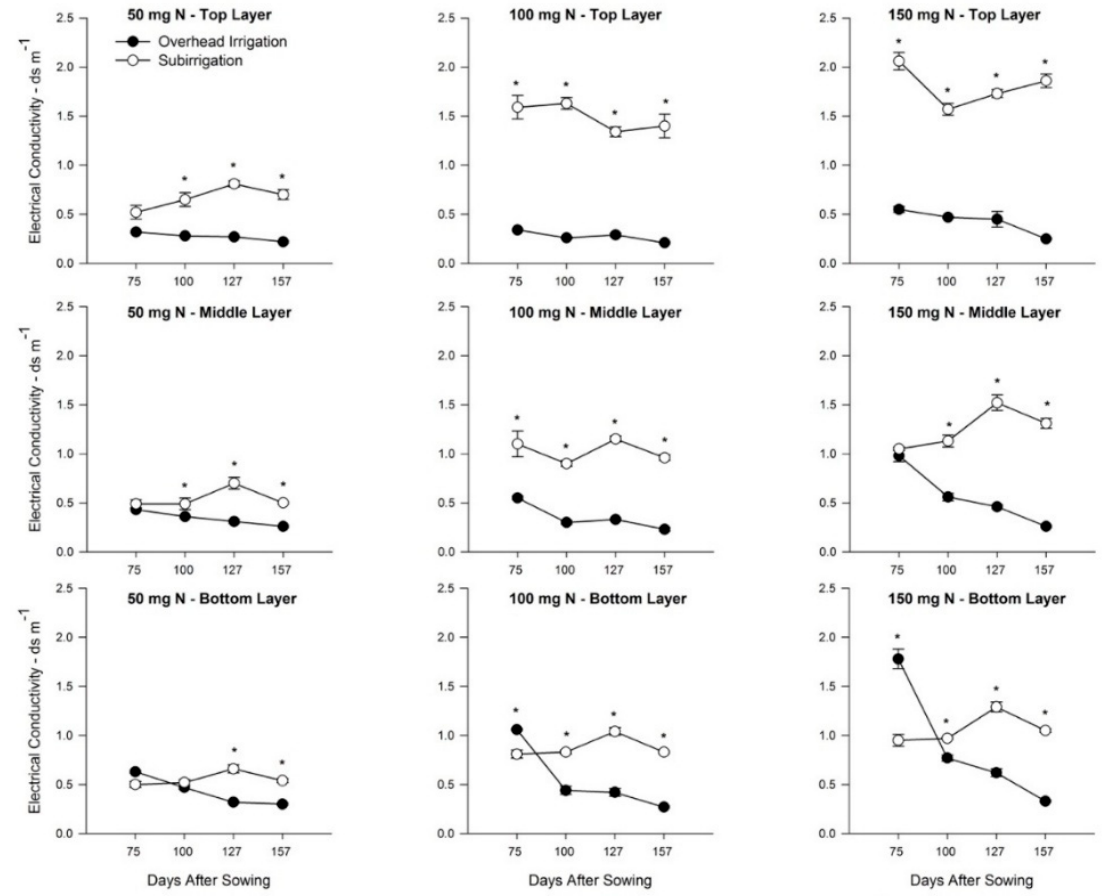
Figure 3. Electrical conductivity (EC, ds m − 1 ) from days 75 to 157 of growing media as measured at three depths (top (3 cm), middle (10 cm), and bottom (17 cm)) in the seedling containers for each combined irrigation method and fertilizer rate treatment. An asterisk indicates a significant difference within a given fertilizer rate treatment and media layer according to Tukey’s honestly significant difference test at α = 0.05.